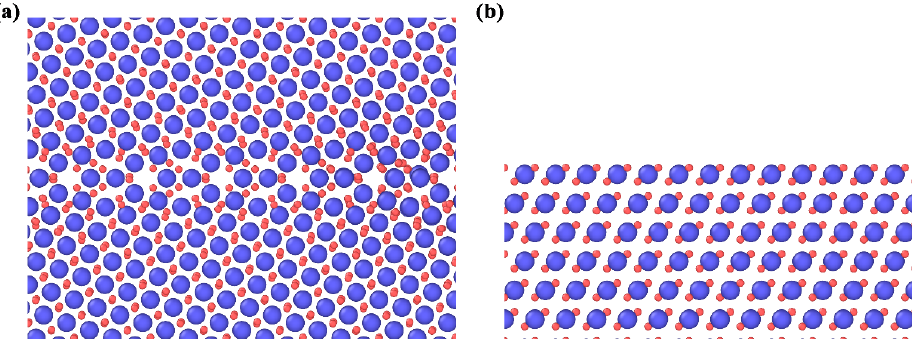
Figure 1. Cubic ZrO 2 models with ( a ) ∑5(130) 100 grain boundaries and ( b ) (130) surface. Herein, the blue particles are the Zr 4+ ions and the red ones are associated with O 2 ions.